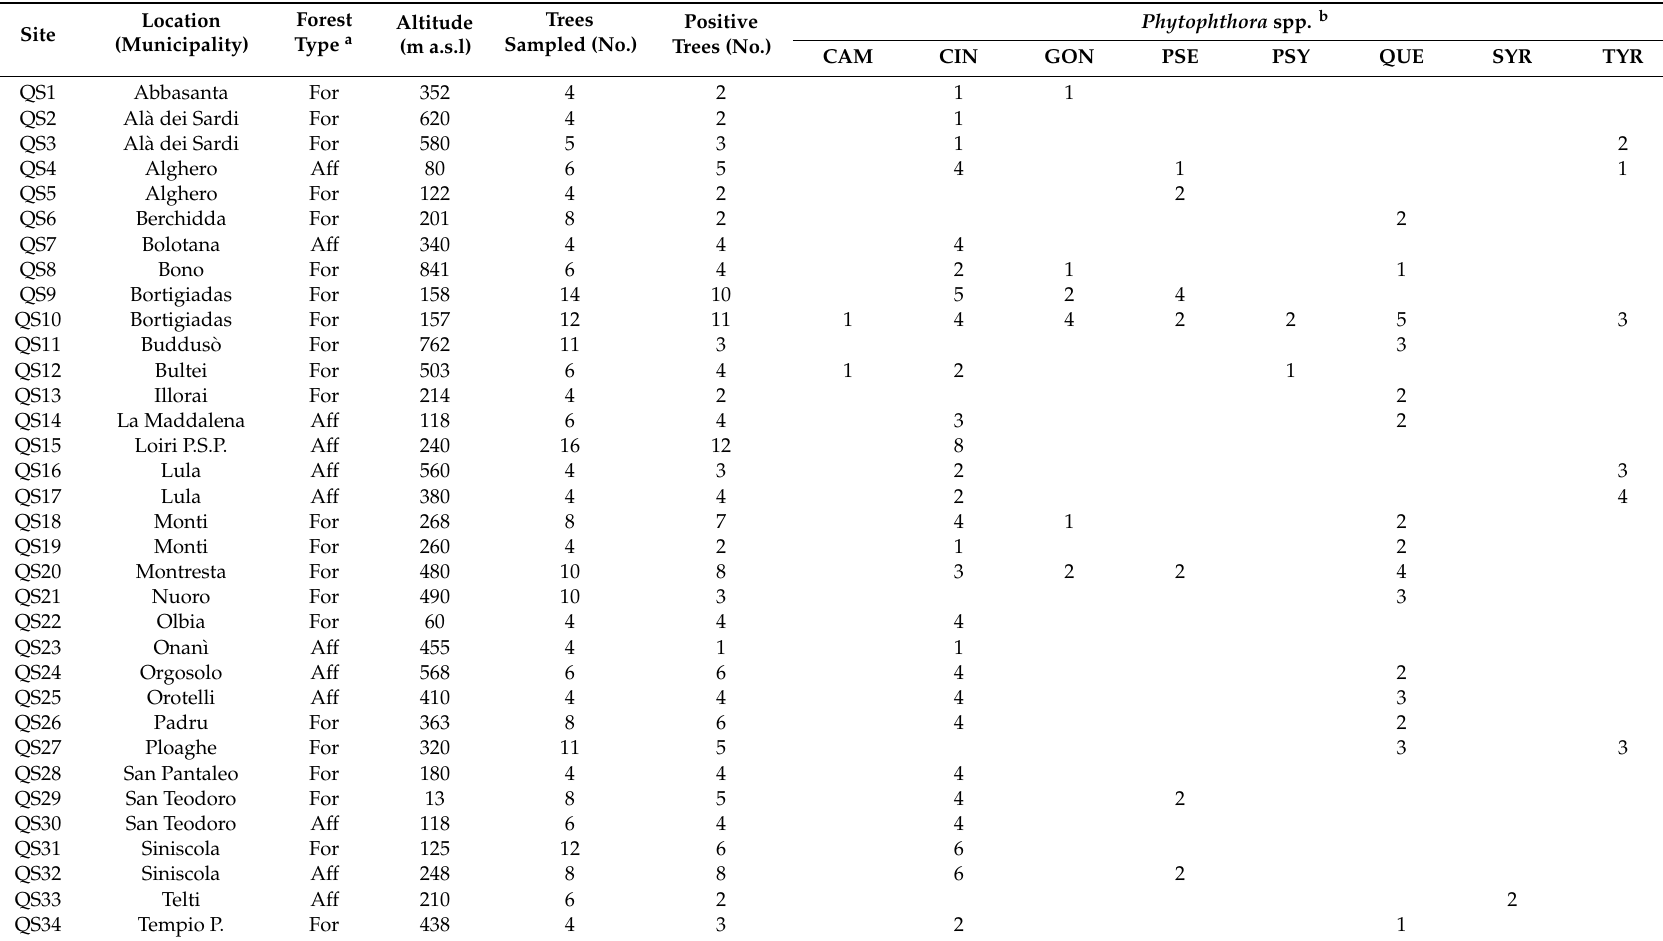
Table 1. Location, forest type, and altitude of the 39 declining cork oak stands sampled in Sardinia and Phytophthora taxa isolated from the rhizosphere soil samples collected in this